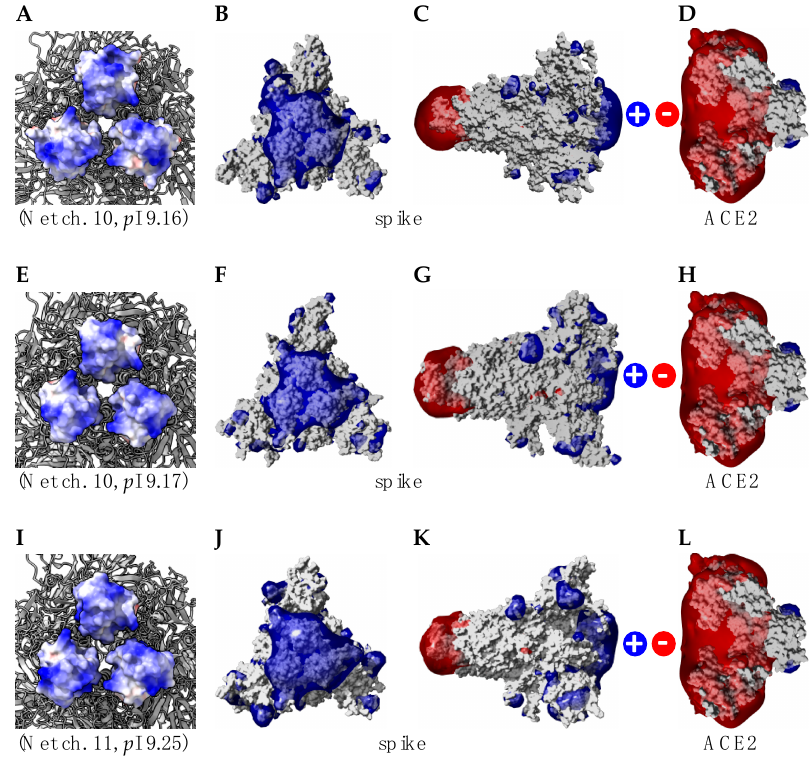
Figure 6. ( A , E , I ) Distribution of electrosatic potentials on the molecular surface of RBDs from omicron BA.1 lineage ( A ), omicron BA.2 lineage ( E ) and omicron BA.3 lineage ( I ). Net charge and calculated isoelectric point ( p I) values are indicated for each RBD. ( B , F , J ) Distribution of the electrostatic potentials calculated with the ESPPME method on the molecular surface of the top face of homotrimeric spikes from omicron BA.1 lineage ( B ), omicron BA.2 lineage ( F ) and omicron BA.3 lineage ( J ). ( C , G , K ) Distribution of the electrostatic potentials calculated with the ESPPME method on the molecular surface of the lateral face of homotrimeric spikes from omicron BA.1 lineage ( C ), omicron BA.2 lineage ( G ) and omicron BA.3 lineage ( K ). ( D , H , L ) Distribution of electrosatic potentials on the molecular surface of a lateral view of the ACE2 receptor for SARS-CoV-2 RBDs. In all cartoons, electropositively and electronegatively charged areas are colored blue and red, respectively, while neutral surfaces are white.